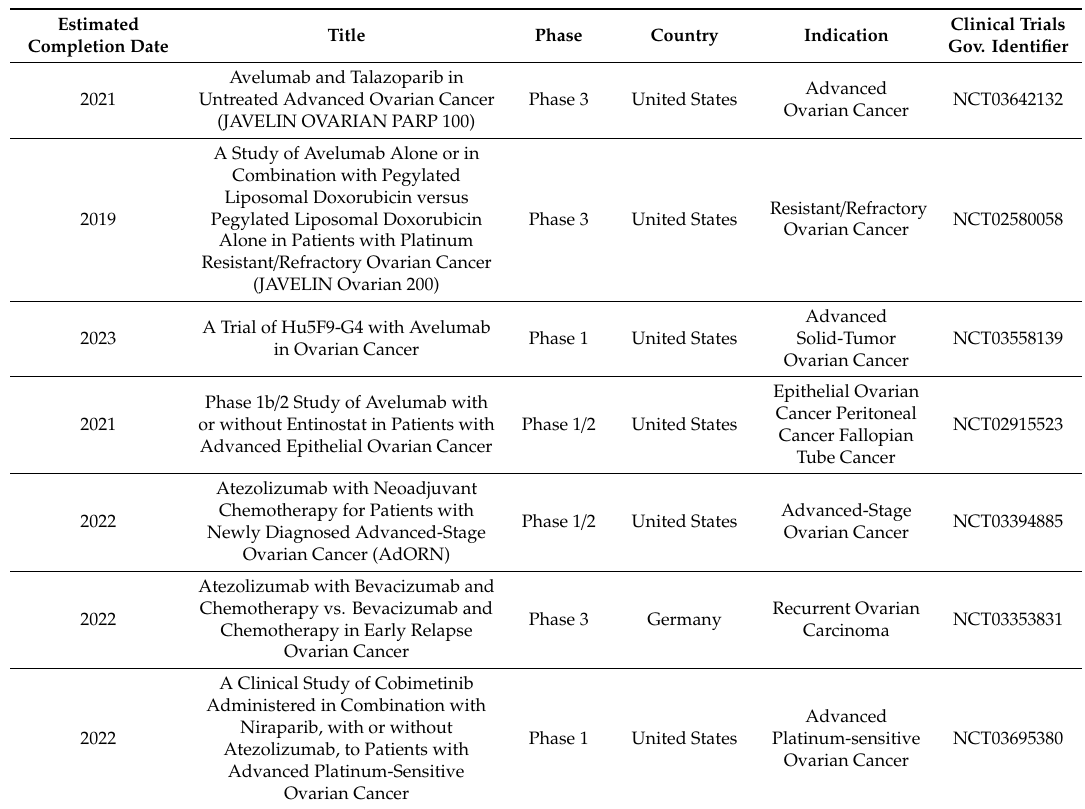
Table 4. Ongoing trials (up to February 2020) of PD-L1 inhibitor monotherapy or in combination with chemotherapy in ovarian